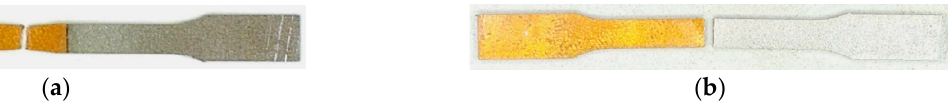
Figure 10. Fracture strength and joint efficiency evaluated for adhesion part (overlap length: 0.3 mm).